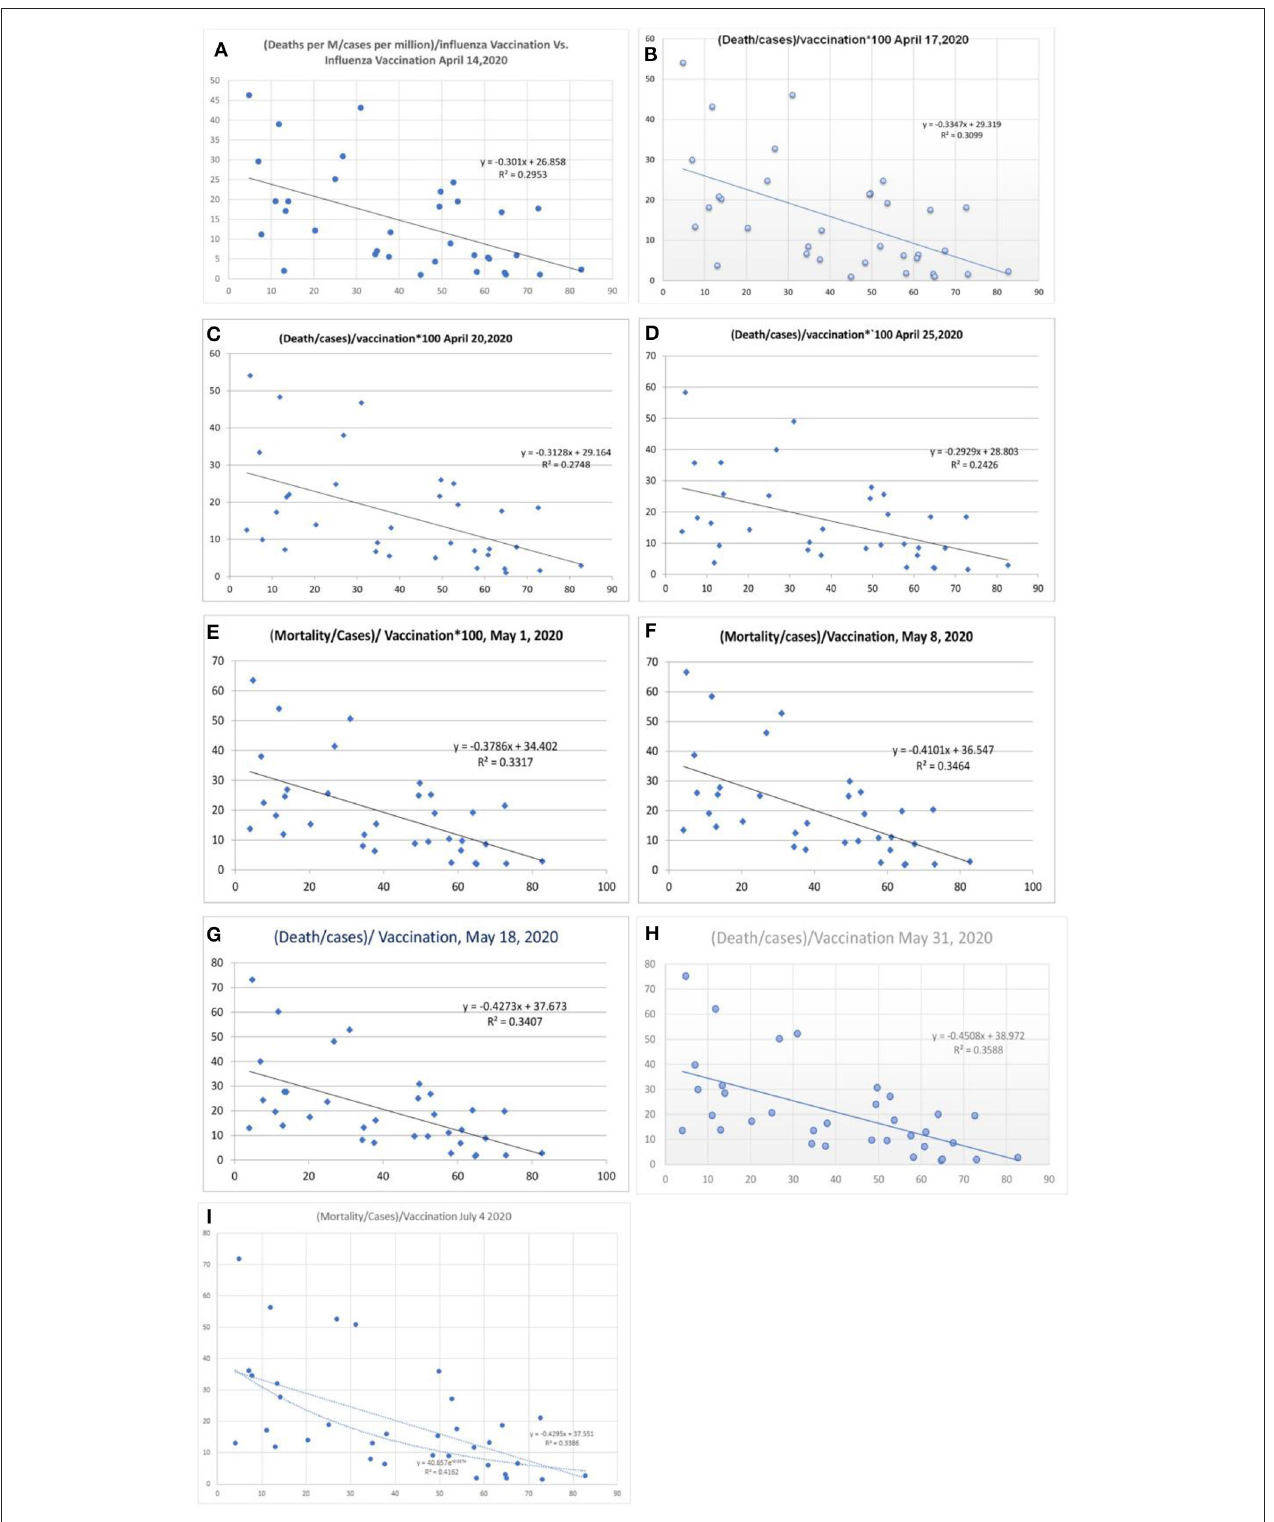
FIGURE 3 | Correlation between influenza vaccination percentage vs. [(deaths/million)/cases per million]/vaccination [ (A) April 14, 2020, (B) April 17, 2020, (C) April 20, 2020, (D) April 25, 2020, (E) May 1, 2020, (F) May 8, 2020, and (G) May 18, 2020, (H) May 31, 2020, and (I) July 4, 2020].